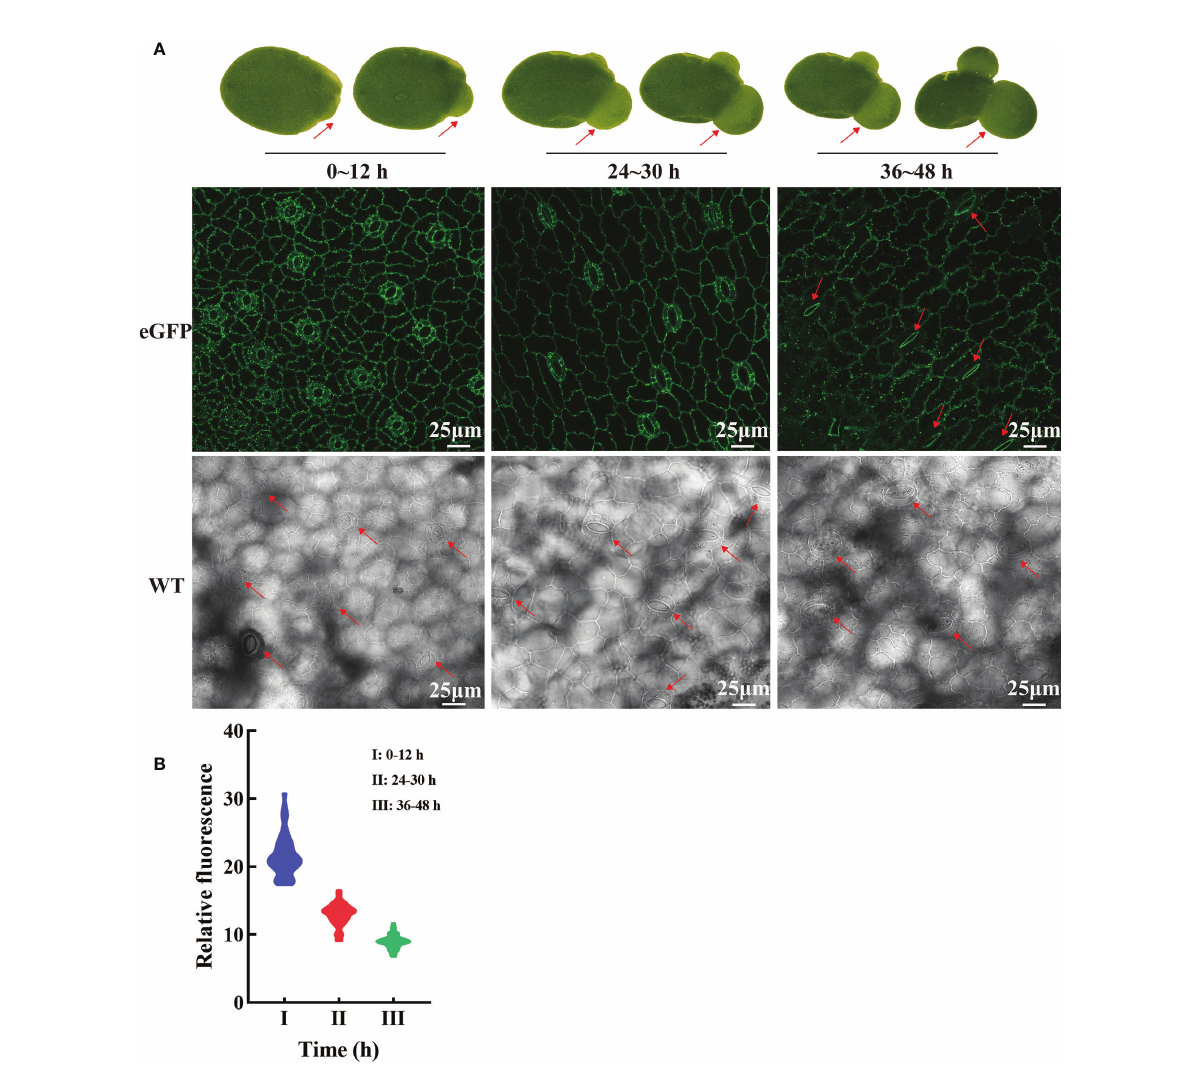
FIGURE 7 Dynamic changes of LpSUT2 subcellular localization in duckweed growth and development. In the initial stages of overexpressed fronds development, the LpSUT2:eGFP fusion protein is evenly distributed in the PM of the guard cells (0-12 h). It gradually formed polar distribution, with the LpSUT2:eGFP expressed only on the endomembrane at the mature stage (36-48 h) (A) . The relative fl uorescence intensity of at least 40 guard cells was quanti fi ed with a laser scanning confocal microscope (B) . The red arrow points to the guard cell. Scale bars: 25 m m. PM, plasmalemma; LpSUT2, Sucrose transporter 2 of L. punctata ; eGFP, Enhanced green fl uorescent protein; WT, Wild